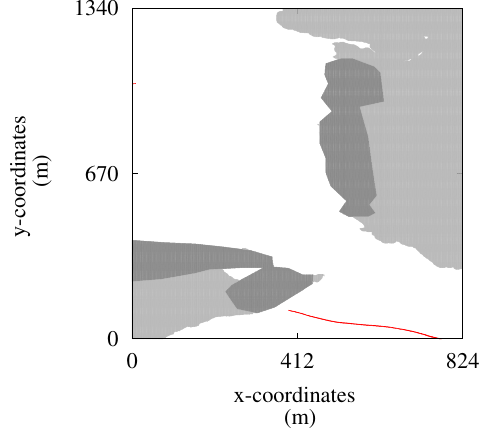
Figure 5. Woodland key habitats (dark gray) and areas with reduced terrain transportation cost from driving through the WKH area (light gray), Case